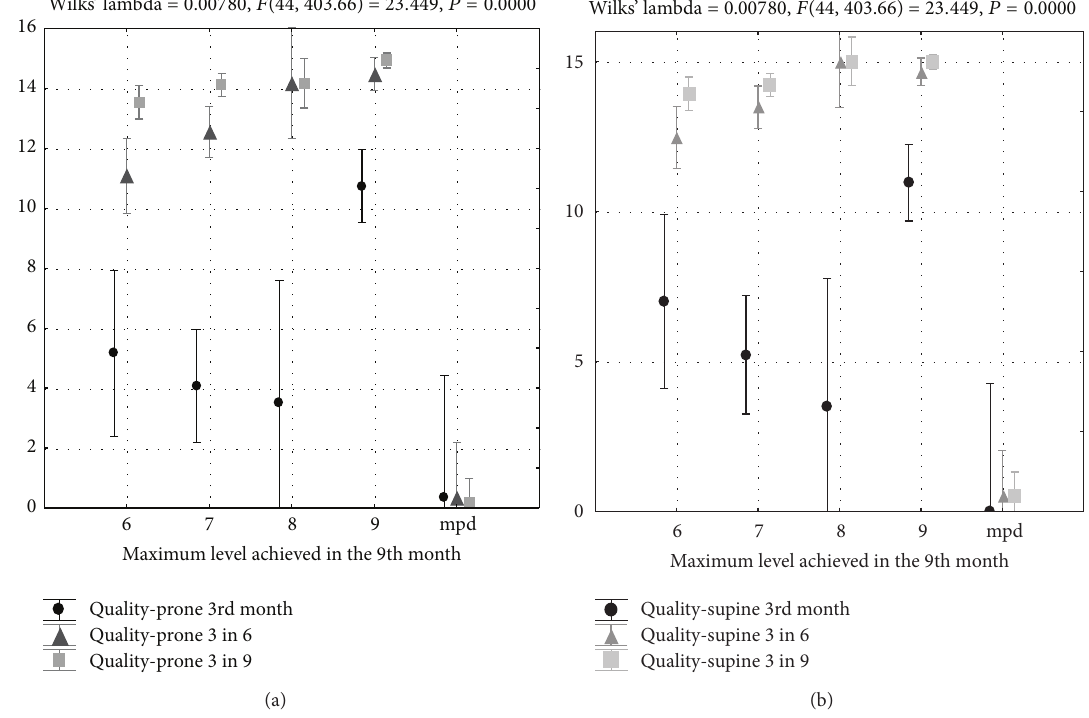
Figure 3: Final neurological diagnosis and qualitative assessment of motor performance at 3, 6, and 9